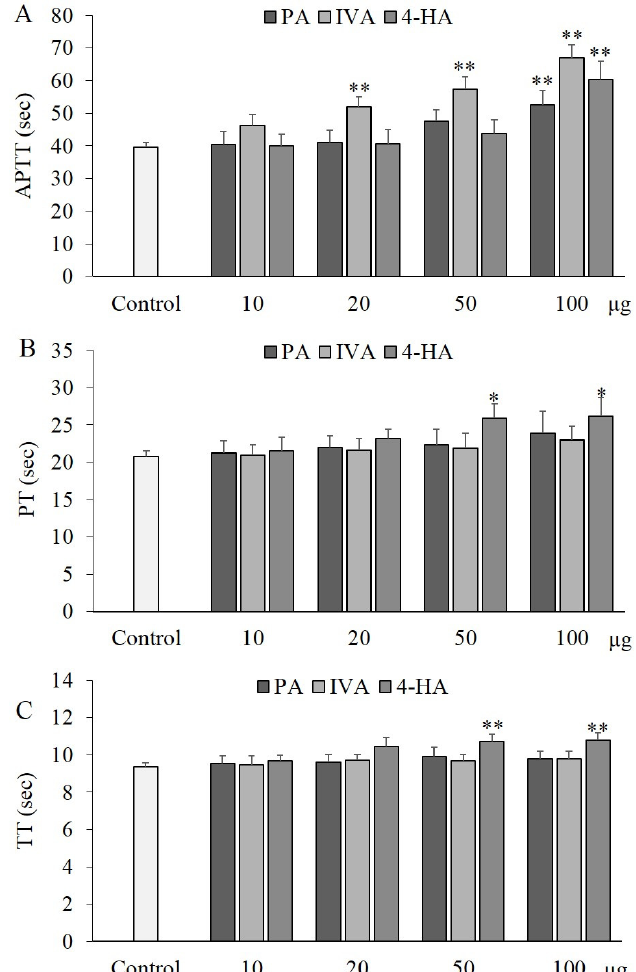
Figure 6. Anticoagulant effect of PA, IVA, and 4-HA. After pretreatment of the compounds with human plasma for 10 min, APTT ( A ), PT ( B ), and TT ( C ) were determined by a coagulometer (Thrombostat 1). Each value is the mean ± SD of triplicate measurements. * p < 0.05 and ** p < 0.01, compared to each control groups.